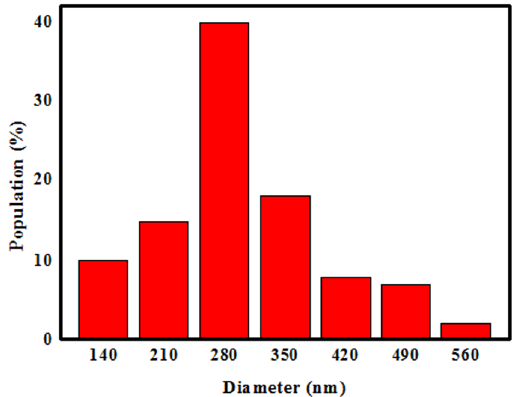
Figure 3. The width distribution histogram of the white, wool-like, products obtained from the inner wall of the ceramic